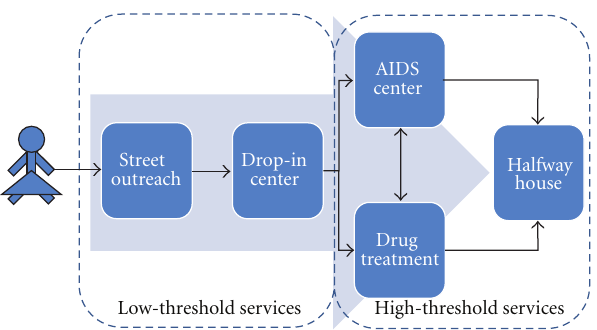
Figure 4: Comprehensive services for street-involved girls and young